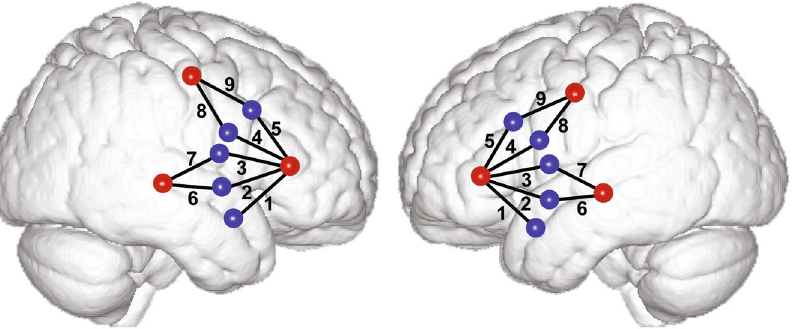
Figure 5. fNIRS probe arrays. Approximate positions of emitting (red circles) and detecting (blue circles) optodes are shown on a standard brain atlas (ICBM 152). The probes were placed symmetrically over both hemispheres, with channels 1–5 spanning inferior frontal gyrus, channels 6–7 over superior temporal gyrus, and channels 8–9 over precentral gyrus/premotor